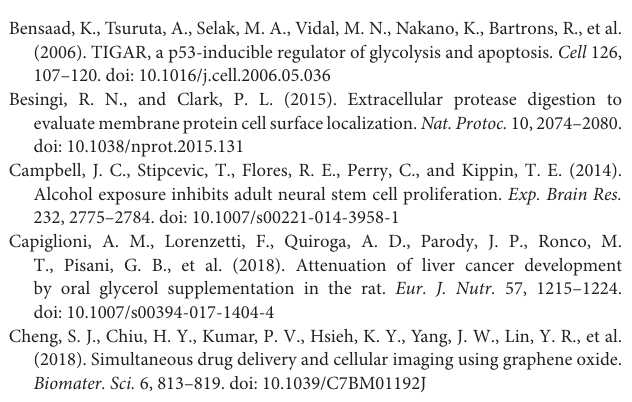
Supplementary Figure 1 | Total ion chromatogram from neural stem cells cultured within different systems using GC-MS. (A) total ion chromatogram from NSC cultured on TCPS. (B) Total ion chromatogram from NSC cultured on 2D graphene system. (C) Total ion chromatogram from NSC cultured in 3D graphene system. (D) Total ion chromatogram from QC sample. Supplementary Figure 2 | Multivariate statistical score graph among three groups. (A) PCA score plot of 3DG and TCPS. (B) OPLS-DA score plot of 3DG and TCPS. (C) PLS-DA score plot of 3DG and TCPS. (D) Statistical validation with permutation analysis (200 times) of the corresponding PLS-DA model of 3DG and TCPS, R 2 is the explained variance, and Q 2 is the predictive ability of the model. Supplementary Figure 3 | volcano map of 3D graphene, 2D graphene and TCPS. (A) 2DG vs. TCPS. (B) 3DG vs. 2DG. (C) 3DG vs. TCPS. up regulation (red), down regulation (green). The horizontal axis is log2 (Fold change), and the vertical axis is –log10 ( P -value), each dot represents a gene, and the two lines parallel to the Y axis are X = 1 and X = − 1, respectively. The point on the right side of X = 1 is a gene that is up-regulated by a factor of two or more, and the point on the left side of X = − 1 is a gene that is down-regulated by a factor of two or more. At the same time, there is a dotted line Y = –log10 (0.05) parallel to the X axis, and a point above the dotted line indicates a gene with a significance P < 0.05. Significantly differentially expressed genes with > 2-fold up-regulated genes are marked in red and down-regulated genes are marked in blue. In addition, the difference significance is < 2 times and is marked with gray. Moreover, the farther away from the distance between the two axes of X = 1 and X = − 1, the greater the variation of the gene represented by this point between the two groups. Through the volcano map, we can clearly see the difference in metabolites of neural stem cells cultured from three different materials. Compared with the 3DG and 2DG groups and the 3DG and TCPS groups, the significant metabolites were significantly better than the 2DG and more than TCPS groups. Supplementary Figure 4 | (A) Metabolites-metabolites correlations of 3DG vs. TCPS. (B) Bubble diagram of differential metabolic pathways in 3DG vs. TCPS group. Supplementary Table 1 | Changes in metabolite-related enzymes in two-dimensional graphene and ordinary slides. Supplementary Table 2 | Changes in differential metabolite-related enzymes in three-dimensional graphene and two-dimensional graphene groups. Supplementary Table 3 | Metabolic pathways and the KEGG ID in this study. Datasheet 1 | Metabolites change in three comparable groups. Datasheet 2 | Metabolites-metabolites correlations in three comparable